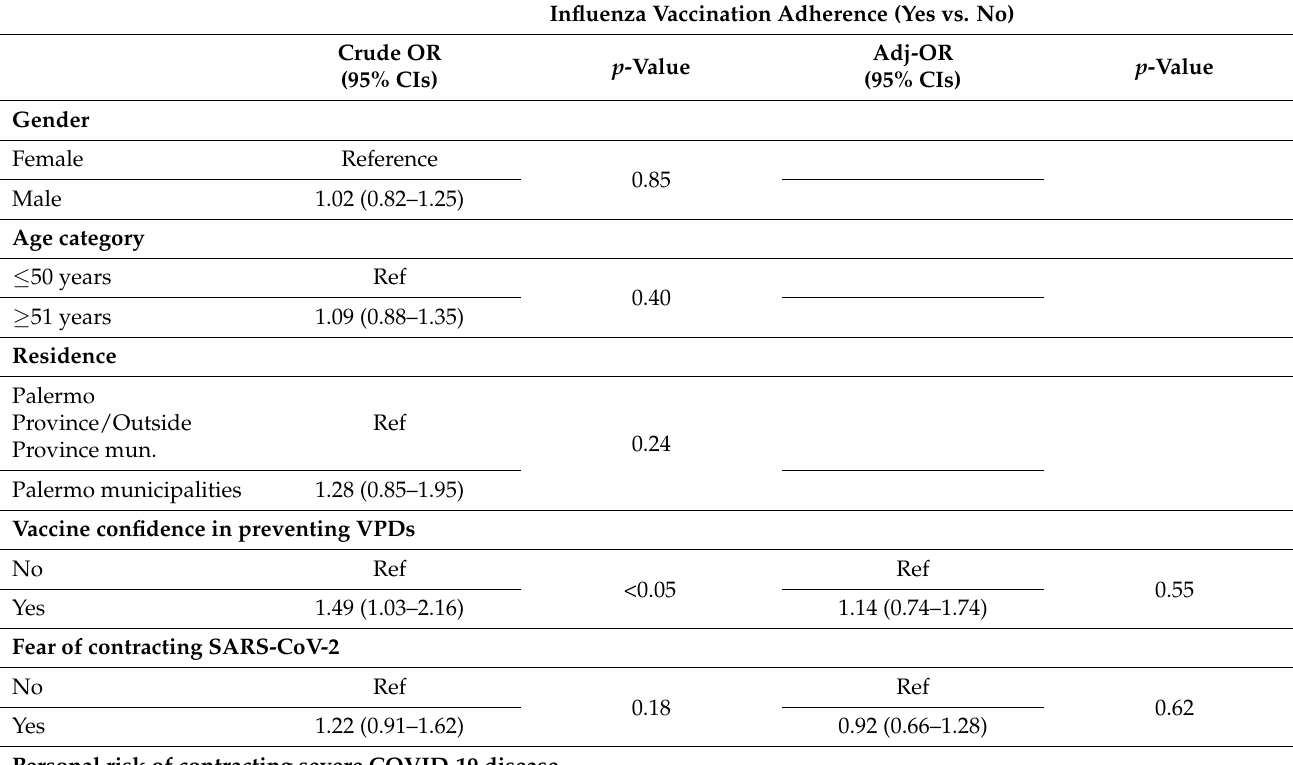
Table 3. Factors associated with influenza vaccination adherence in the univariable (crude OR) and multivariable (adj OR) analyses among study participants in the baseline survey ( n = 1450) (95% CI: 95% confidence